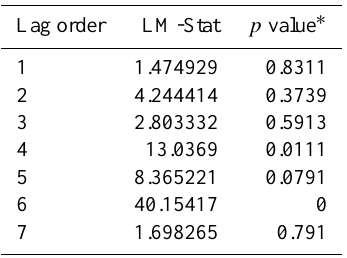
Table 11. VAR Residual Serial Correlation LM Tests component of Granger causality testing of relationship between second-difference CO 2 and SOI. Preferred 3-lag model.